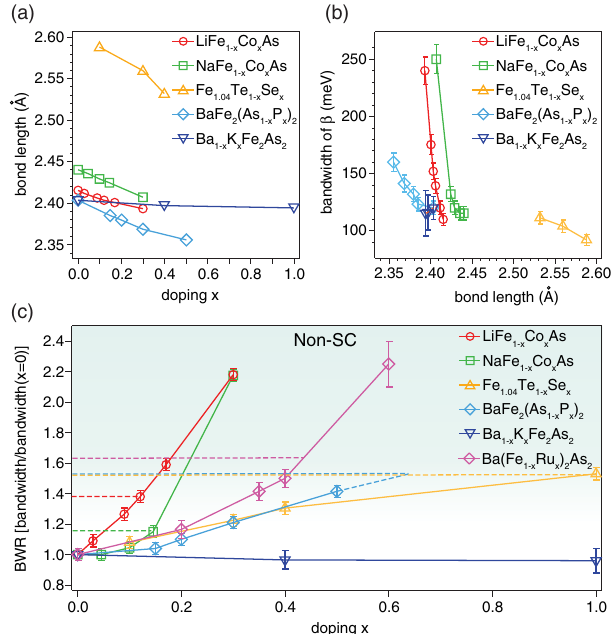
FIG. 5. (a) Evolutions of the Fe-As bond length in LiFe 1 − x Co x As, NaFe 1 − x Co x As, BaFe 2 ð As 1 − x P x Þ 2 , and Ba 1 − x K x Fe 2 As 2 , or the Fe-Te bond length in Fe 1 Te 1 − x Se x . . 04 The bond length data were extracted from Ref. [46]. Note that, in the case where the bond length data for certain doping-level samples are lacking, we estimate the bond length values by the linear interpolation method. Panel (b) summarizes the evolutions of the β bandwidths as a function of the Fe-As or Fe-Te bond length in these five series. (c) Doping dependence of the β bandwidth normalized by that of its parent compound ( x ¼ 0 ), named BWR (bandwidth ratio) for simplicity, in each series. The horizontal dashed line divides the superconducting region and overdoped nonsuperconducting region of each series. Note that the bandwidth of FeTe, the parent compound of Fe 1 Te 1 − x Se x , . 04 was estimated from a linear extrapolation of data in Fig. 4(e) since the photoemission data of FeTe is intrinsically very broad [47], making it difficult to directly determine its bandwidth. The error bars of β bandwidths or normalized bandwidths in panels (b) and (c) come from the uncertainty in the dispersion